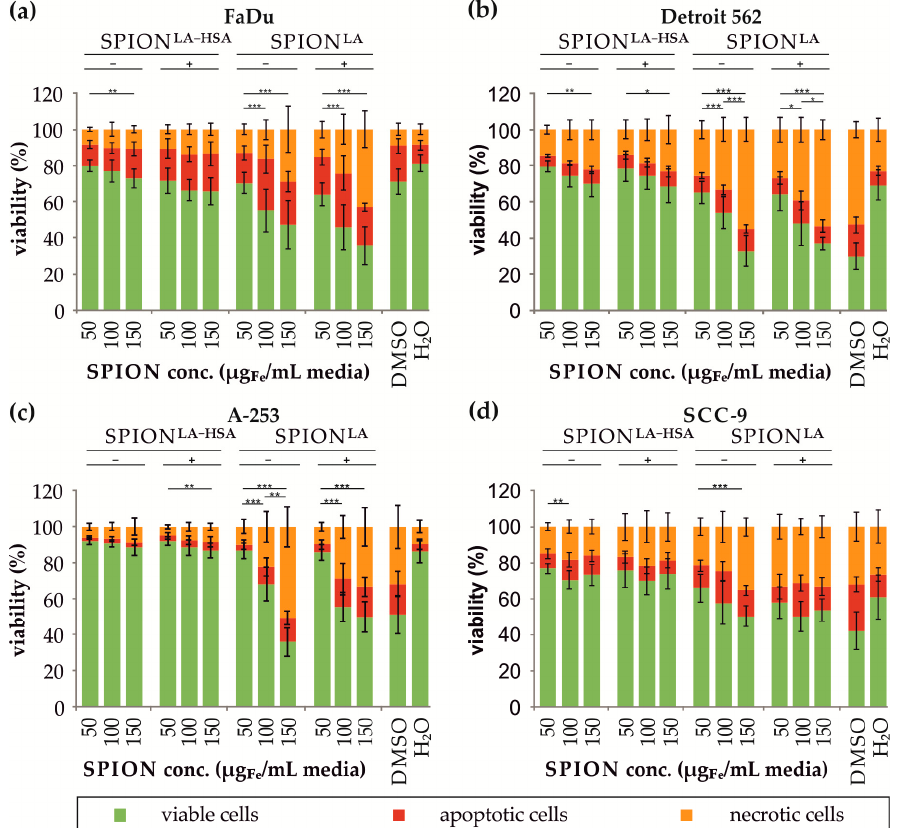
Figure 6. Viability of cell lines after SPION treatment in the presence or absence of magnets. Shown are the amount of viable (Ax- PI-), apoptotic (Ax+ PI-), and necrotic (PI+) cells after treatment of FaDu ( a ), Detroit 562 ( b ), A-253 ( c ) and SCC-9 cells ( d ) with SPION LA or SPIONL A-HSA at concentrations of 50, 100, and 150 µg Fe /mL without (-) or on (+) magnetic plates. Positive controls contain 2% DMSO and negative controls contain H 2 O instead of the SPION suspension. Data are expressed as mean standard deviation (n = 3 with technical triplicates). Statistical significance of viable cells at increased SPION concentration are marked with *, ** and ***. The respective confidential intervals are p ≤ 0.05, p ≤ 0.001, and p ≤ 0.0001 and were calculated using Student’s t -test analysis. Abbrevia-